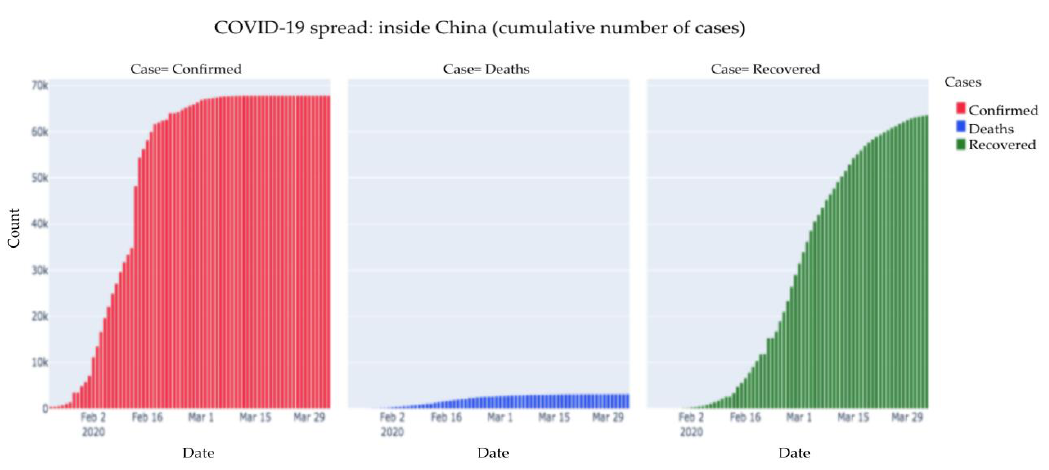
Figure 2. COVID-19 spread: inside China (cumulative number of cases)